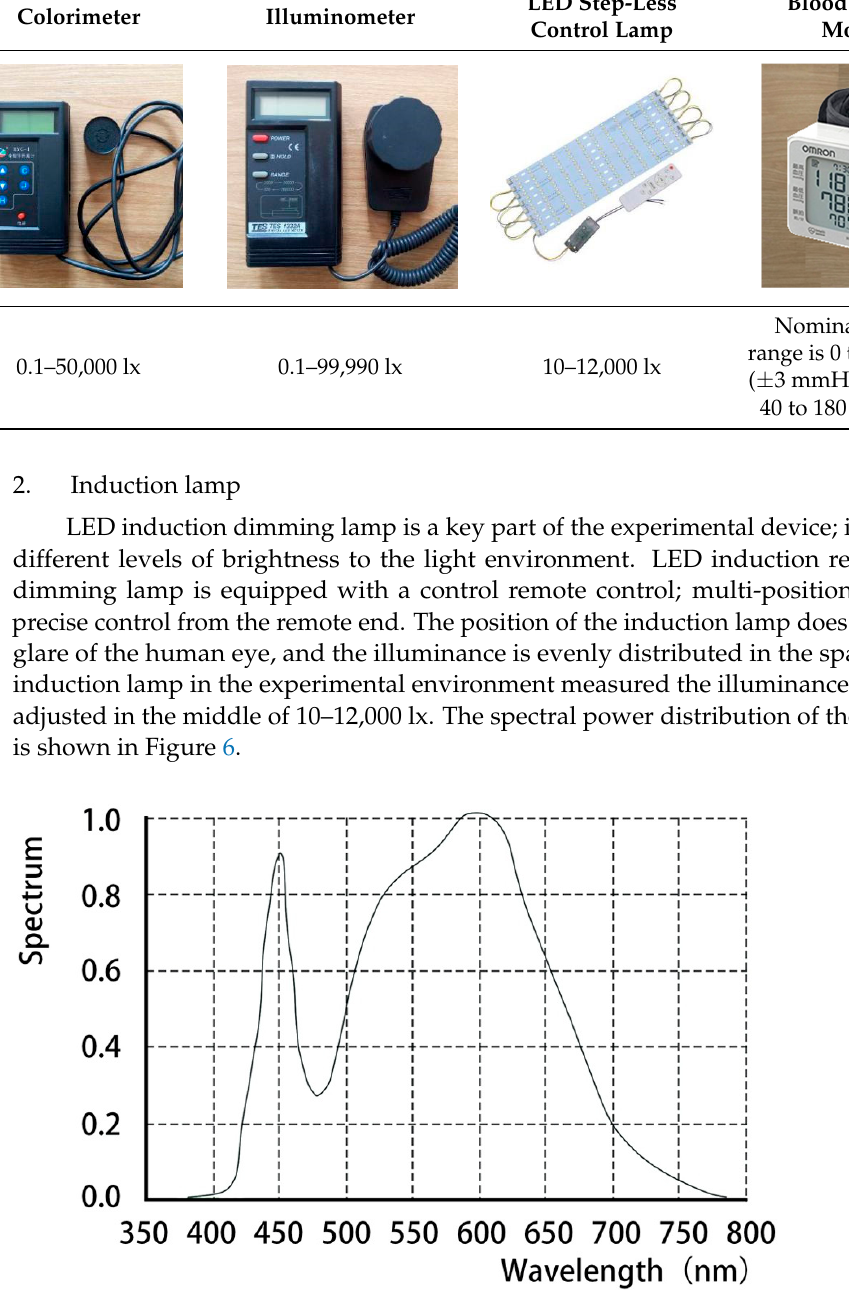
Figure 6. The spectral power distribution of the light source.